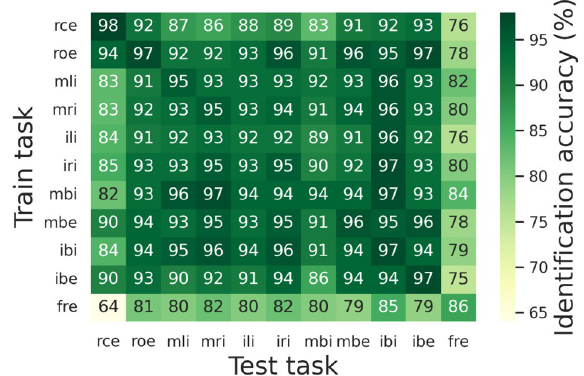
Figure 4. Cross-task personal identification. Each cell in the matrix indicates the mean 10-person identification accuracy of a particular train-test combination. rce = resting with closed eyes, roe = resting with opened eyes, mli = moving left fist, mri = moving right fist, ili = imagining moving left fist, iri = imagining moving right fist, mbi = moving both fists, mbe = moving both feet, ibi = imagining moving both fists, mbe = imagining both feet, fre = free